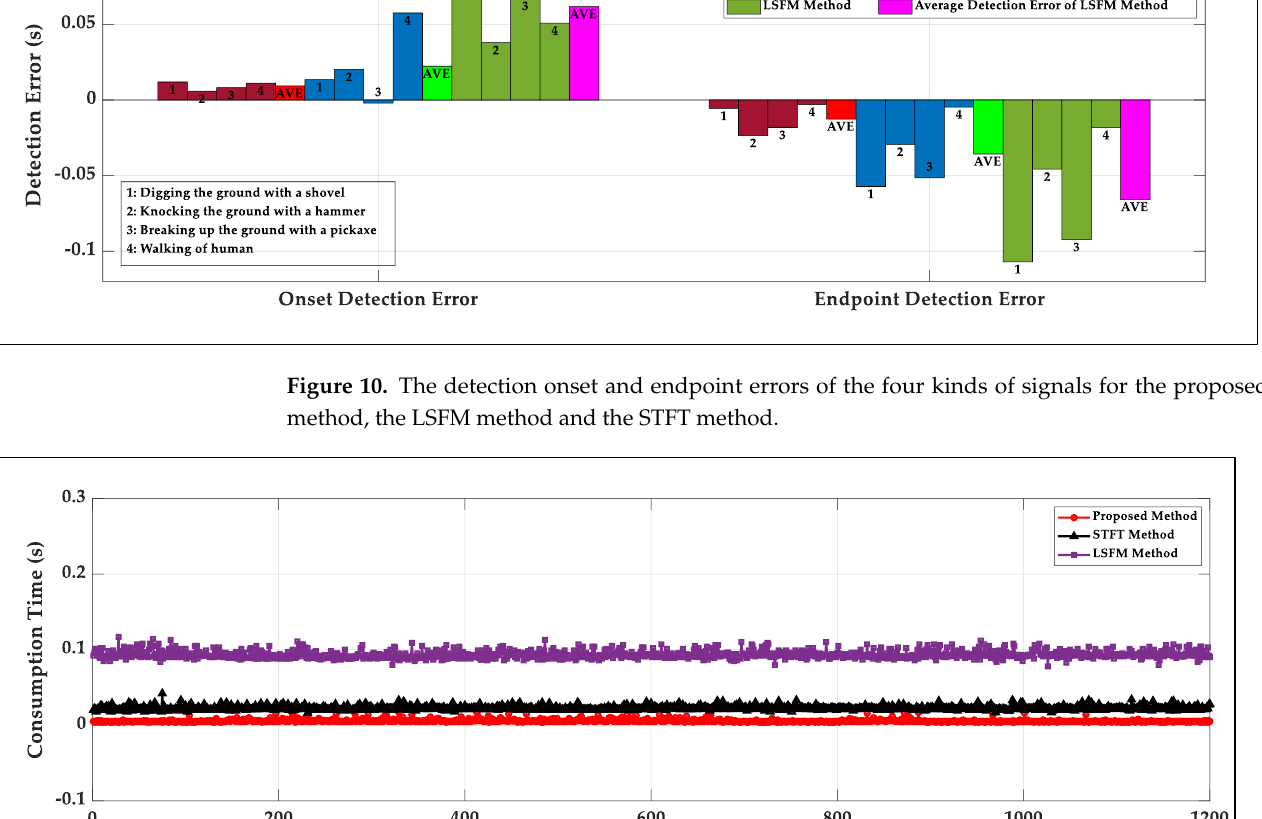
Figure 10. The detection onset and endpoint errors of the four kinds of signals for the proposed method, the LSFM method and the STFT method.